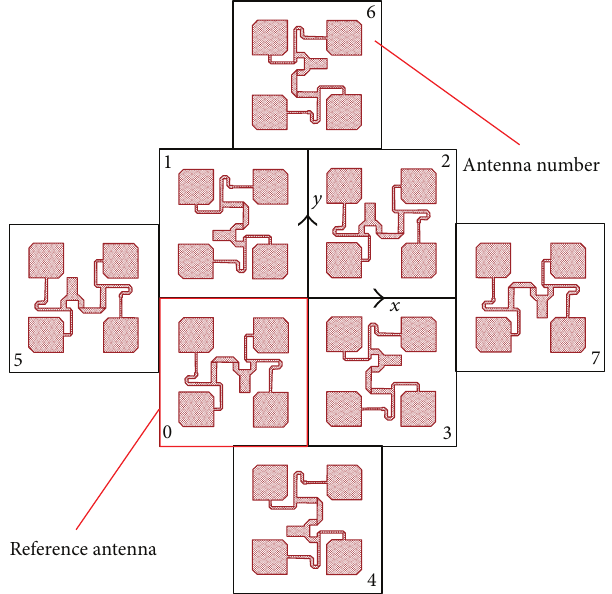
Figure 3: Schematic of a seven-element phased array antenna for power